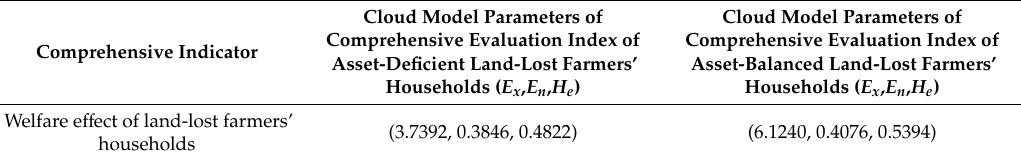
Table 7. Di ff erences in the welfare e ff ects of land-lost farmers’ households under di ff erent livelihood asset allocations.